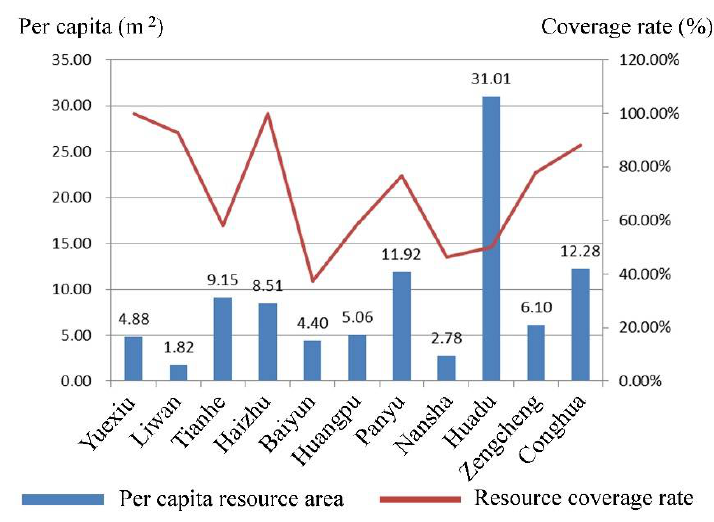
Figure 6. Existing per capita available resource area and coverage rate.